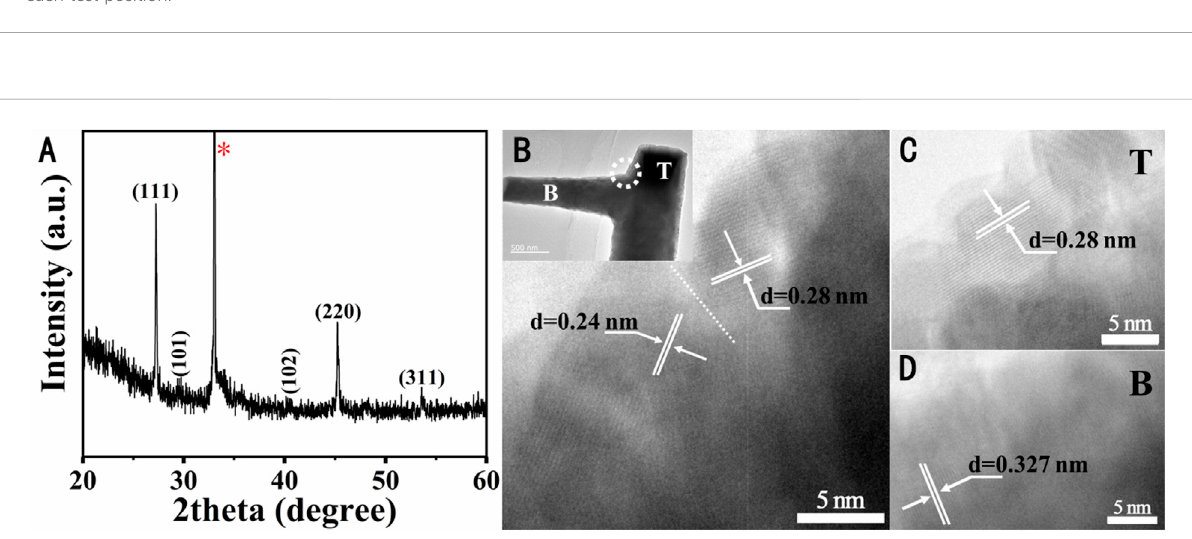
FIGURE 3 (A) XRDspectraofZnSenanowires,labeledwithdiffractionplaneofthezincblende-,wurtzite-ZnSecrystalstructure. (B) HRTEMofthejunction of the trunk and topological branch ofthe topological branched nanowires, and the inset in theupper left corner shows the full view of thisposition. HRTEM of the (C) trunk and (D) topological branched